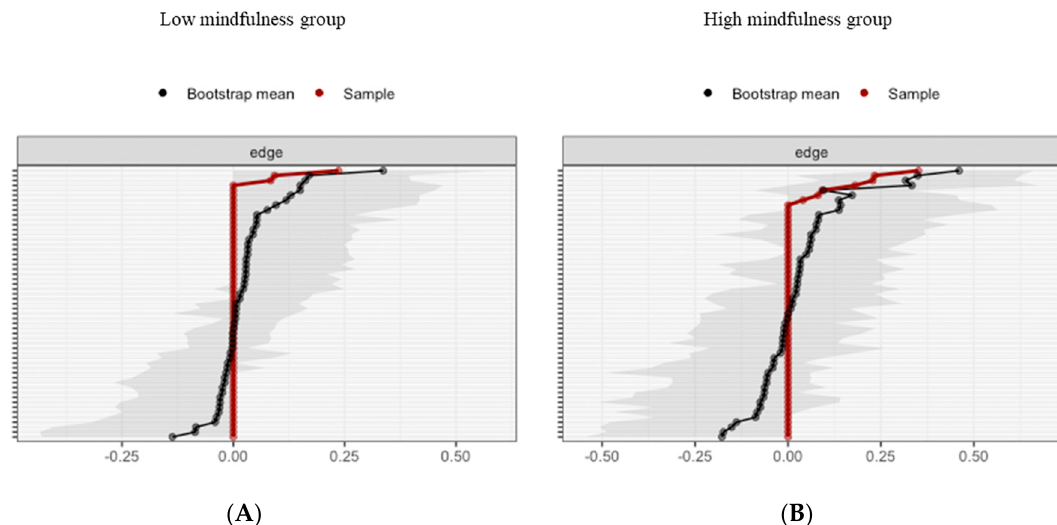
Figure 8. Estimated edge-weights for the estimated network and centrality of nodes. Bootstrapped CIs of estimated edge-weights for the estimated network for the low MD group ( A left) and the high MD group ( B right). The red line indicates the sample values and the gray area the bootstrapped CIs. Each horizontal line represents one edge of the network, ordered from the edge with the highest edge-weight to the edge with the lowest edge-weight.